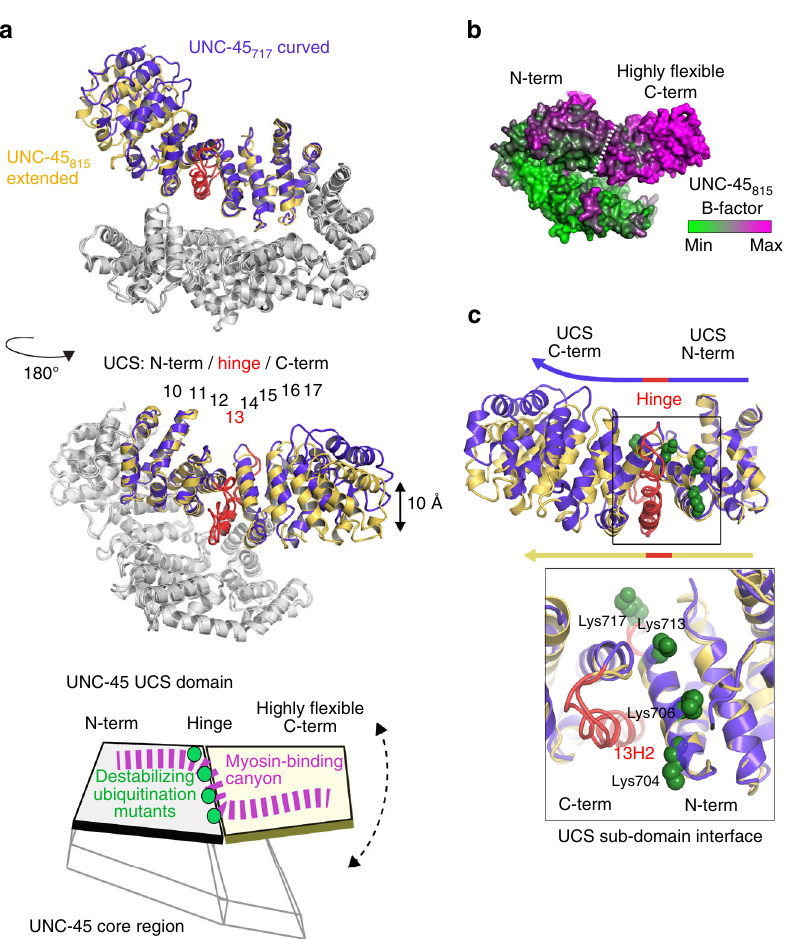
Fig. 5 Location of ubiquitination sites on the fl exible UCS domain of UNC-45. a Upper panel: structural alignment of UNC-45 815 (yellow) and UNC-45 717 (lilac) revealed that ARM repeat 13 (red) serves as a molecular hinge connecting the two UCS subdomains and allowing the domain to adopt distinct overall folds (straightened UCS superhelix in UNC-45 815 , curved superhelix in UNC-45 717 ). The structure on top is depicted in the same orientation as illustrations in Fig. 4. Lower panel: schematic model of UNC-45. Green spheres indicate KR canyon mutations yielding a better UFD-2 substrate. b The subdomain architecture of the UCS domain is also seen when plotting the B factors on the molecular surface (green, rigid; magenta, fl exible). c Ribbon presentation of the UCS domain of UNC-45 815 (yellow) and UNC-45 717 (blue), shown in similar orientation as in Fig. 4. The zoomed-in window shows the KR canyon ubiquitination sites (green spheres) at the subdomain interface, as also indicated in